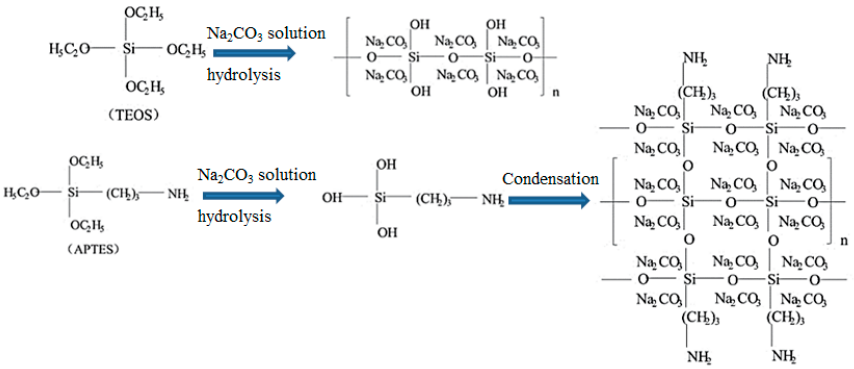
Scheme 3. Interaction mechanism between CO 2 and amino groups ( a ) under dry condition, ( b ) under humid condition.